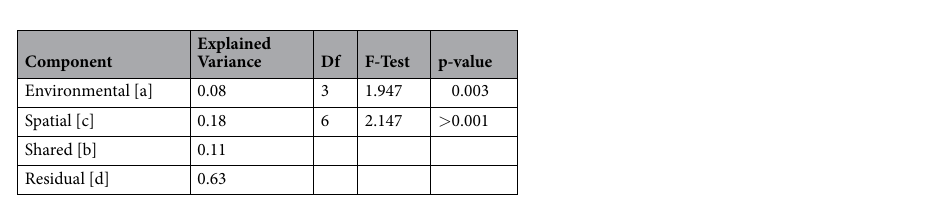
Table 3. Variation partitioning and permutation analysis results for the explained variance of environmental and spatial components on the distribution of sandy beach macrobenthic